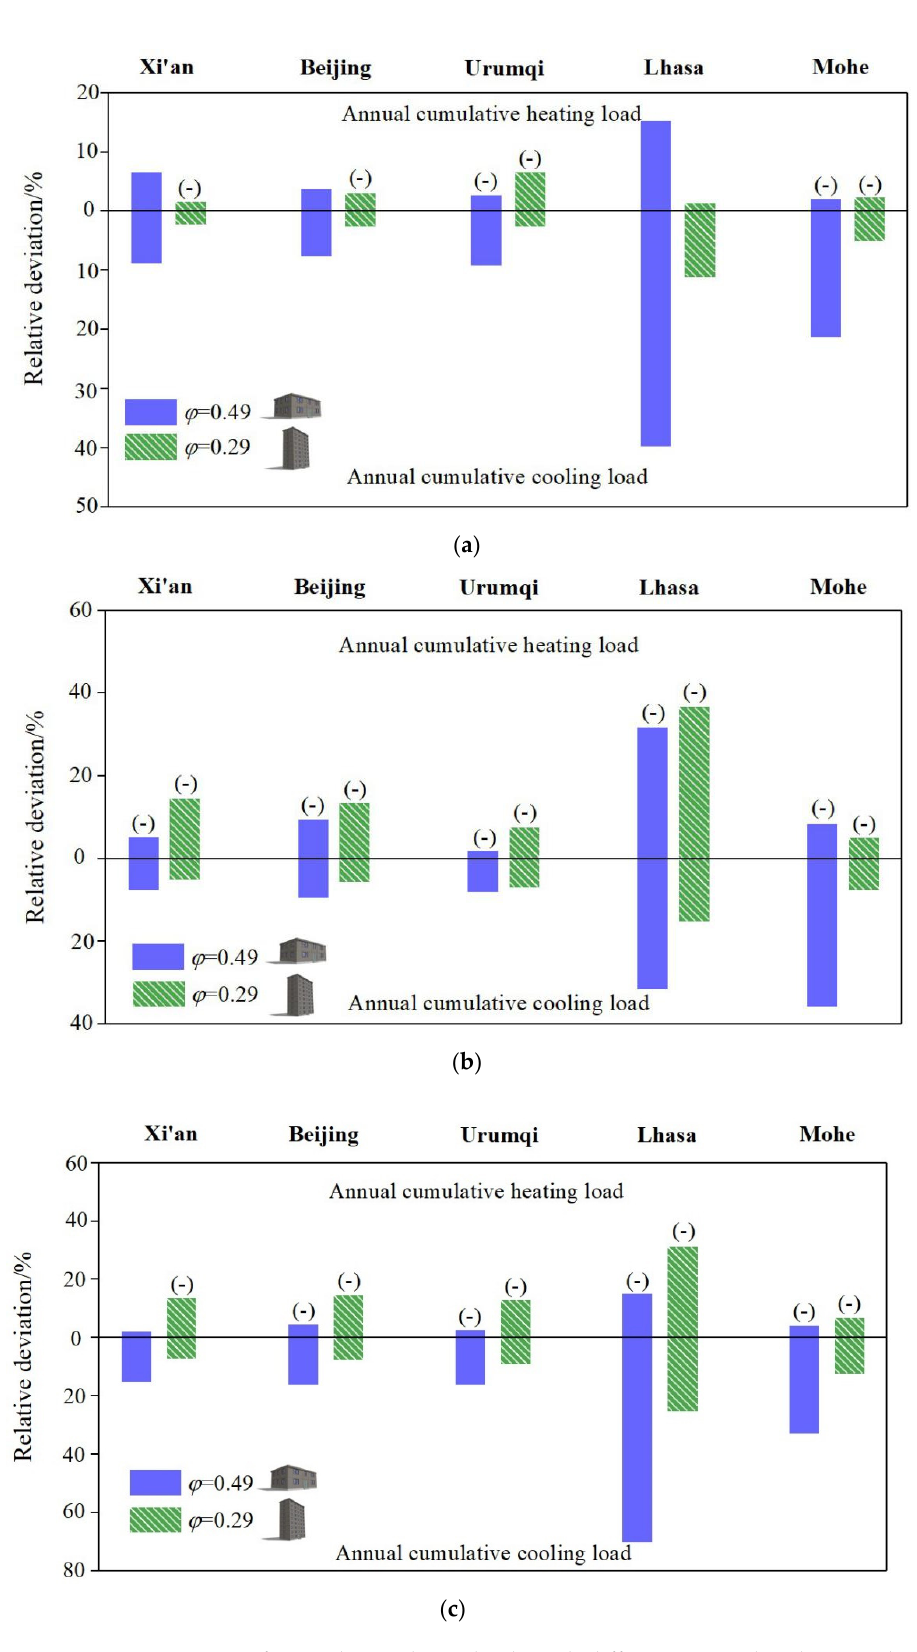
Figure 11. Comparisons of annual cumulative loads with different internal and external SHTCs: ( a ) Indoor side with the TARP model; ( b ) Outdoor side with the TARP model; ( c ) Both sides with the TARP model.